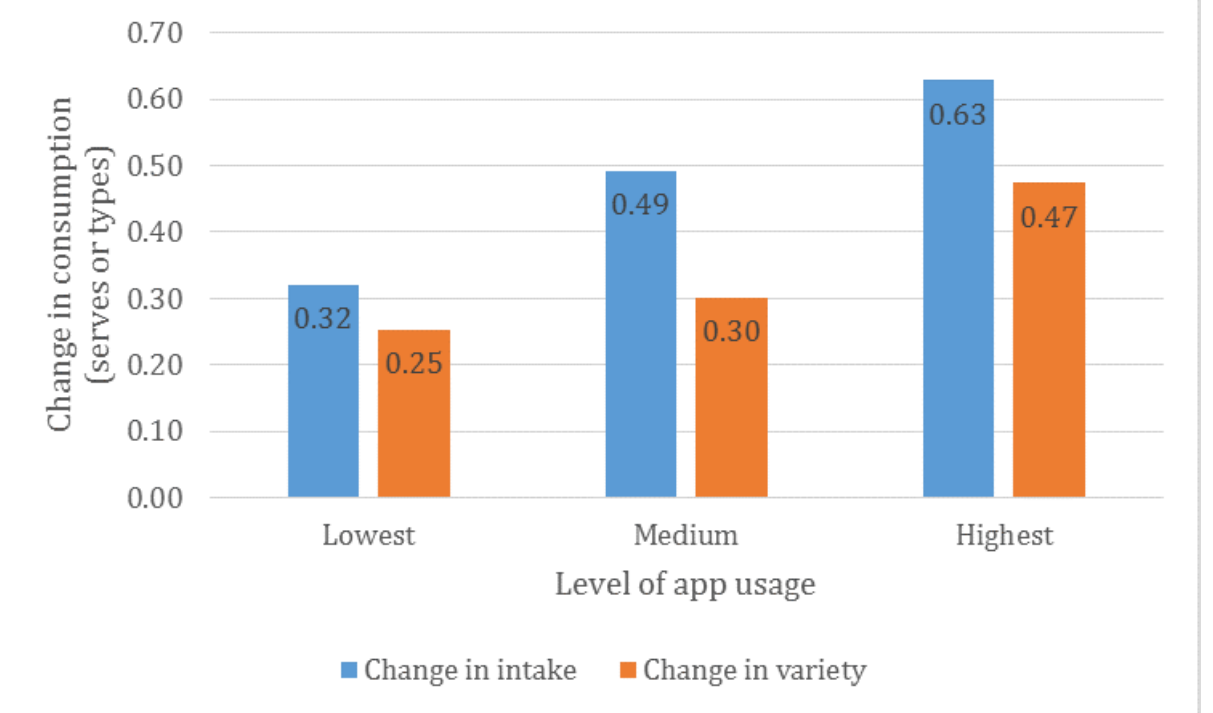
Figure 7. Change in vegetable consumption by level of app usage* (n=1219). *Lowest tertile of app usage: active days ranged from 1 to -10 days, average 6.4 days; medium app usage: active days ranged from 11 to -15 days, average 13.1 days; and high app usage: active days ranged from 16 to -21 days, average 18.3